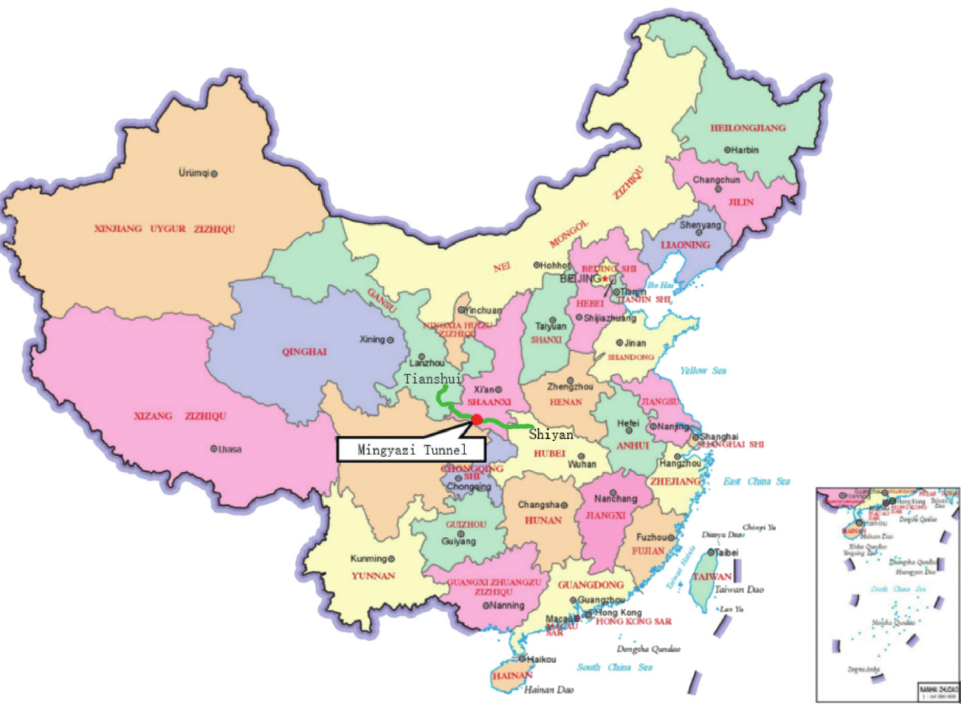
Figure 3: The site of the Mingyazi tunnel in china. Table 1: Engineering geology and support parameters.